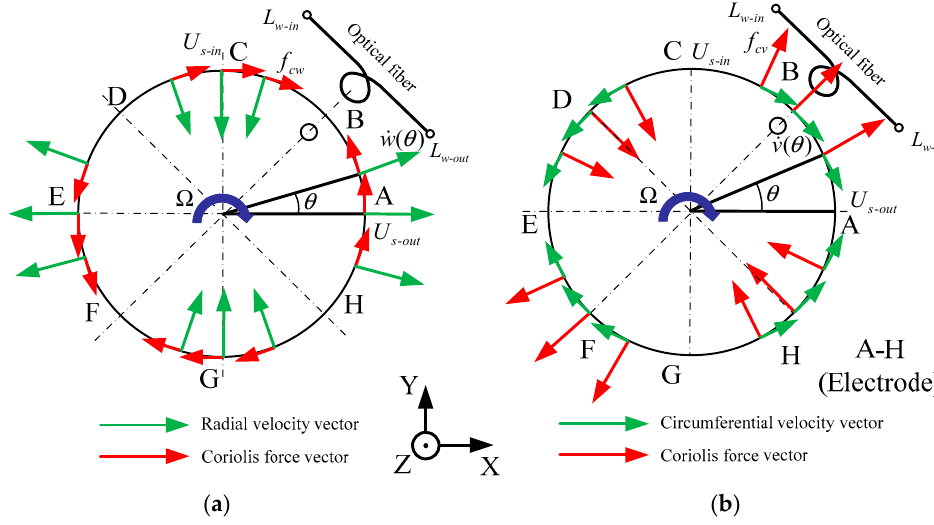
Figure 3. ( a ) Coriolis force vector caused by radial velocity ( b ) Coriolis force vector caused by circumferential velocity.